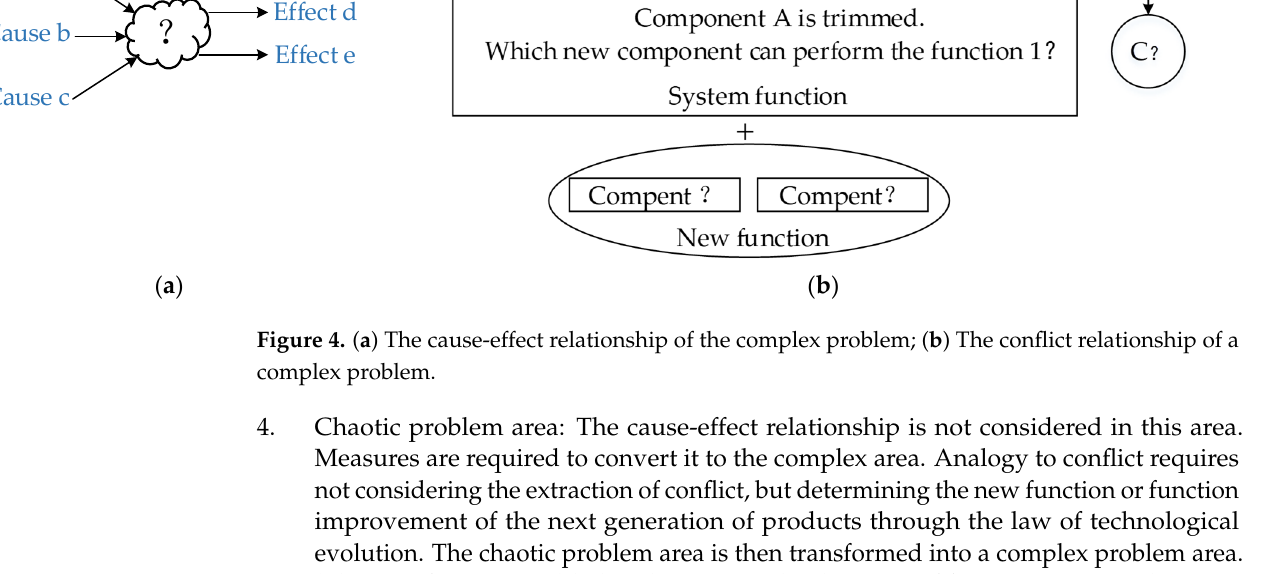
Figure 4. ( a ) The cause-effect relationship of the complex problem; ( b ) The conflict relationship of a complex problem.